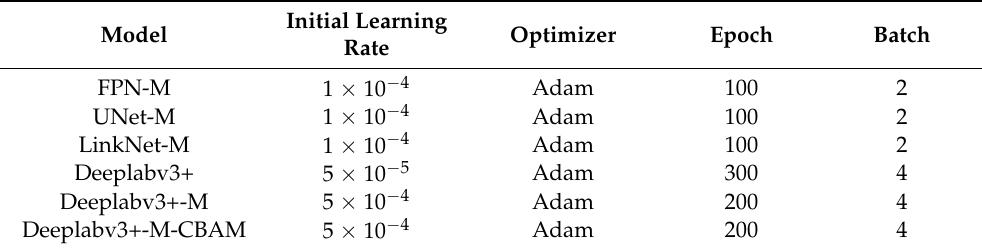
Table 3. Training parameters of the different models. “-M” means using MobileNetV2 as the backbone network.